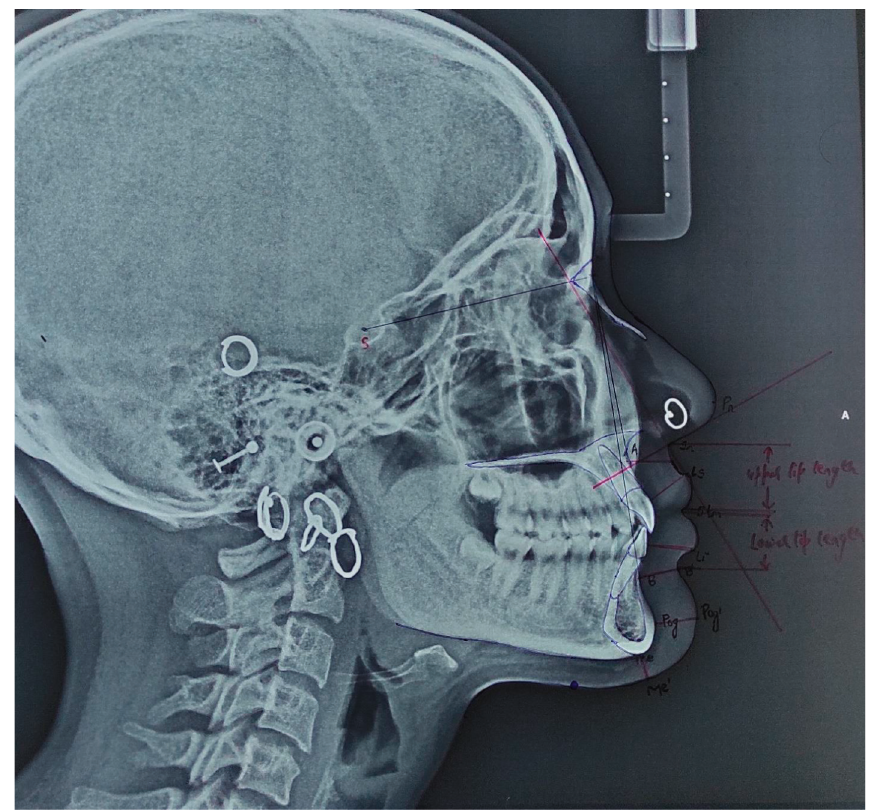
Figure 1: Cephalometric tracing used for the measurement of various soft tissue